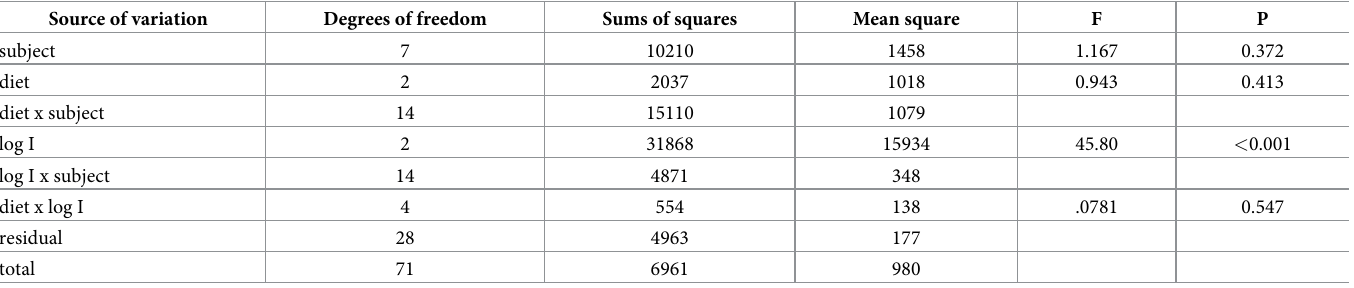
Table 3. Results from a two-way repeated measures ANOVA procedure comparing the effects of dietary taurine levels and light intensity (log I) on flicker fusion frequencies. Only the latter had a significant effect. Source of variation Degrees of freedom Sums of squares Mean